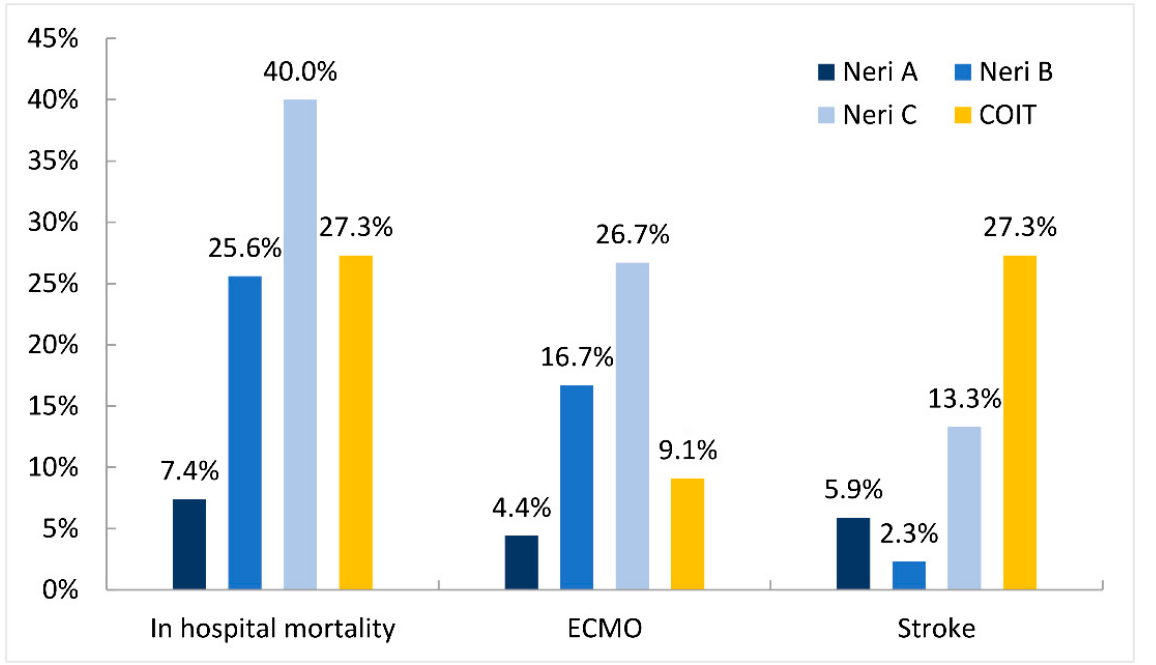
Figure 2. In-hospital mortality, ECMO use, and postoperative stroke for each lesion type. ECMO, extracorporeal membranous oxygenation; COIT, coronary ostium intimal tear.